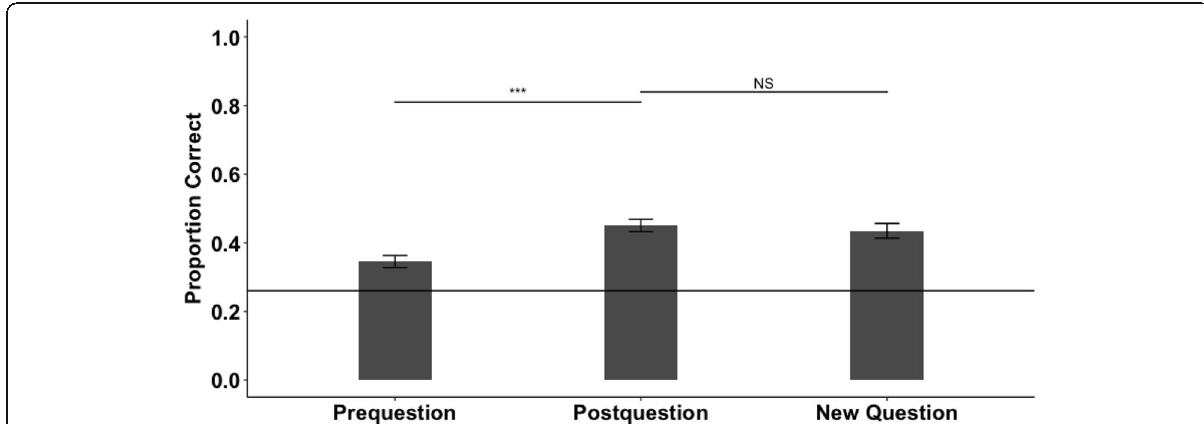
Fig. 3 Proportion correct on in-class questions as a function of question type. Prequestion denotes questions asked at the beginning of class, postquestion denotes the same questions repeated at the end of class, and new question denotes new, never-before-seen questions from the same lessons asked at the end of class. Horizontal line denotes chance performance on the prequestions. Error bars represent standard errors. *** p < 0.001; NS not